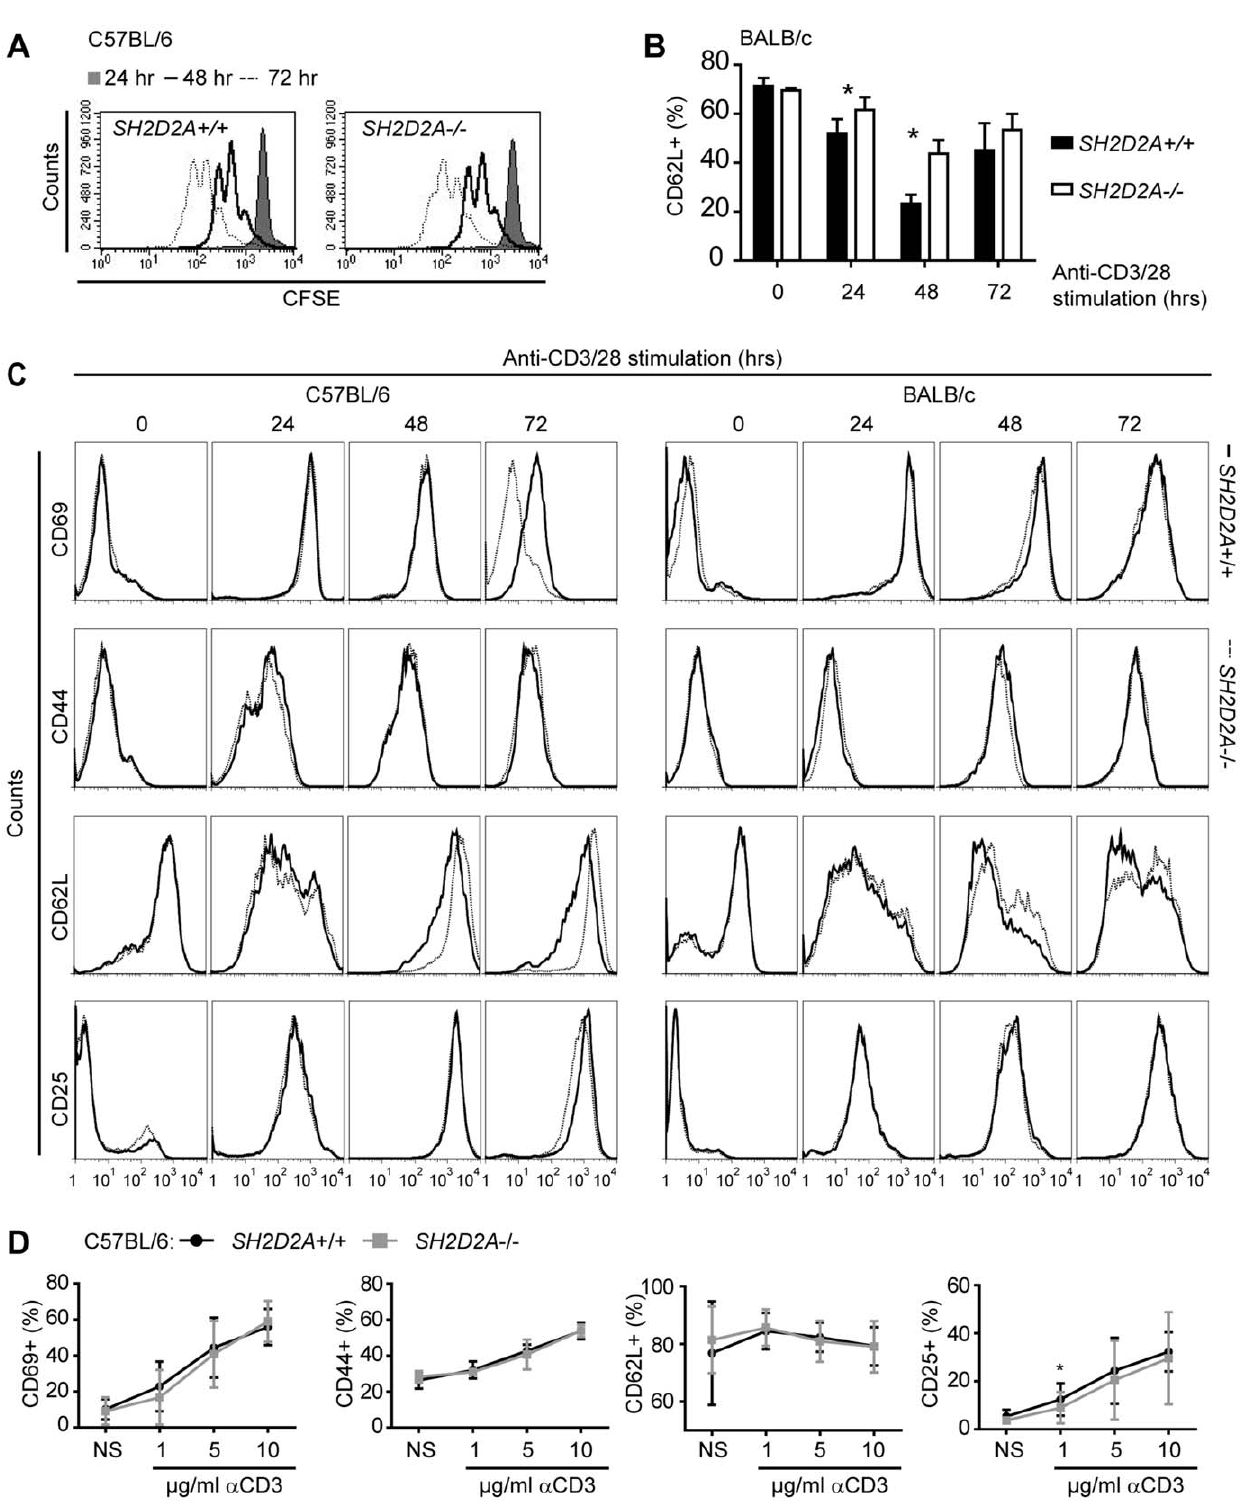
Figure 3. SH2D2A -deficiency does not have a major effect on anti-CD3/CD28 induced CD4 + T cell proliferation or expression of activation markers. (A) CFSE labeled CD4 + T cells from wild-type ( SH2D2A + / + ) and SH2D2A -deficient ( SH2D2A -/-) C57BL/6 mice were cultivated with anti-CD3/CD28 beads as described in materials and methods. After 24, 48 and 72 hours, cells were harvested and the CFSE dilutions of SH2D2A + / + CD4 + T cells (left diagram) and SH2D2A 2 / 2 CD4 + T cells (right diagram) were measured by flow cytometry. Grey area - CFSE profiles after 24 hours, open area (black line) - CFSE profiles after 48 hours and open area (stippled line) - CFSE profiles after 72 hours in culture with anti-CD3/CD28 beads. (B, C) Unlabeled CD4 + T cells from SH2D2A + / + and SH2D2A 2 / 2 C57BL/6 (C, left side) and BALB/c (B and right side of C) mice were cultivated as in A. Prior to and after 24, 48 and 72 hours, cells were stained with CD69, CD44, CD62L or CD25 mAbs to assess T cell activation. (B) The percentage of